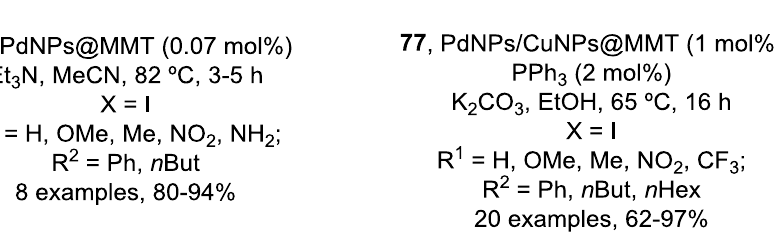
Figure 23. Montmorillonite-immobilized PdNPs as catalysts for the Sonogashira reaction. Conditions, substrate scope and yield range (Scheme 2).